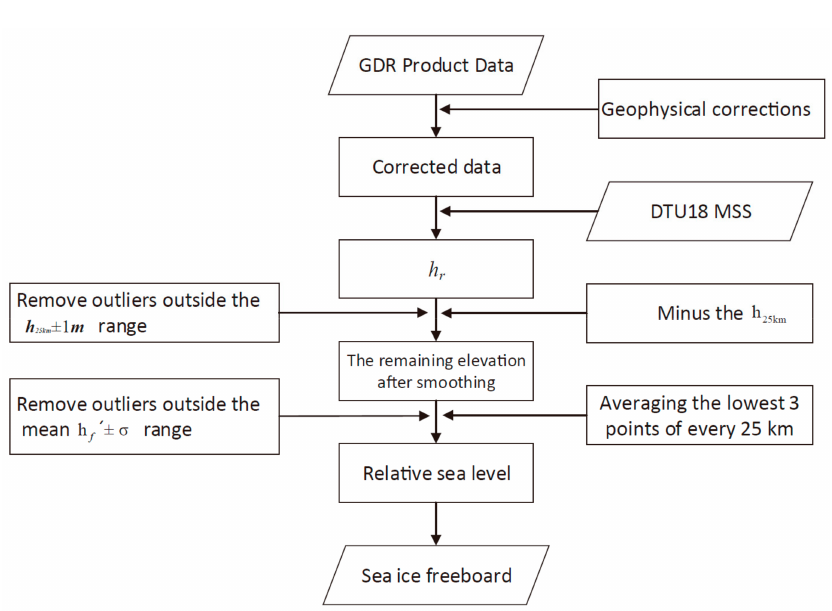
Figure 1. A flowchart of the freeboard retrieval